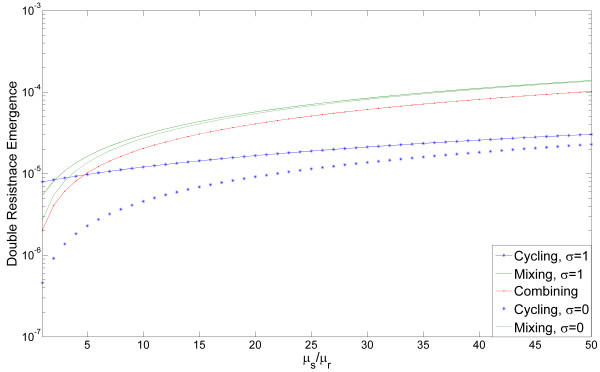
Emergence of double resistance as a function of the effect of stress on mutation. The double resistance emergence for each strategy is plotted, in log scale, as a function of μsμr, which varies from 1 to 50. Note that lower emergence values indicate higher efficiency of the strategies. Mixing is plotted in green, cycling in blue, and combining in red. Double resistance emergence is monotonically increasing in σ (persistence of antibiotic resistance), so curves with intermediate values of σ will be within the boundaries of the curves σ = 0 and σ = 1 displayed. The value of σ is irrelevant for combining, so only one curve is produced. An intersection of the curves implies that the preference between two strategies, with respect to the emergence of double resistance, should change. We can see that for a wide range of μsμr, cycling is the most efficient strategy. When σ is low enough, cycling is the most efficient strategy even without SIM. The emergence is taken over 600 days. The length of each cycle in the cycling strategy is 200 days. Other parameter values: β = 0.9, γ = 0.03, m = 0.1, λs = 0.1, λR1=0.1, λR2=0.1, τ = 0.5. SIM, stressed-induced mutation.